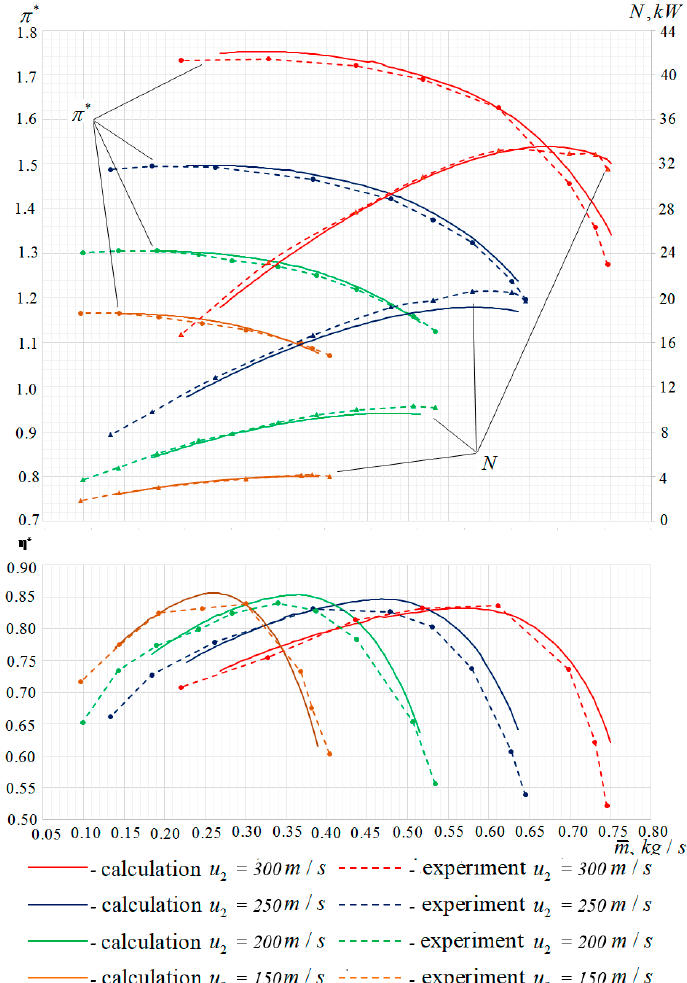
Figure 9. Comparison of design and actual characteristics of the TKR 140E compressor at blade velocity u = 150, 200, 250 and 300 m/s.